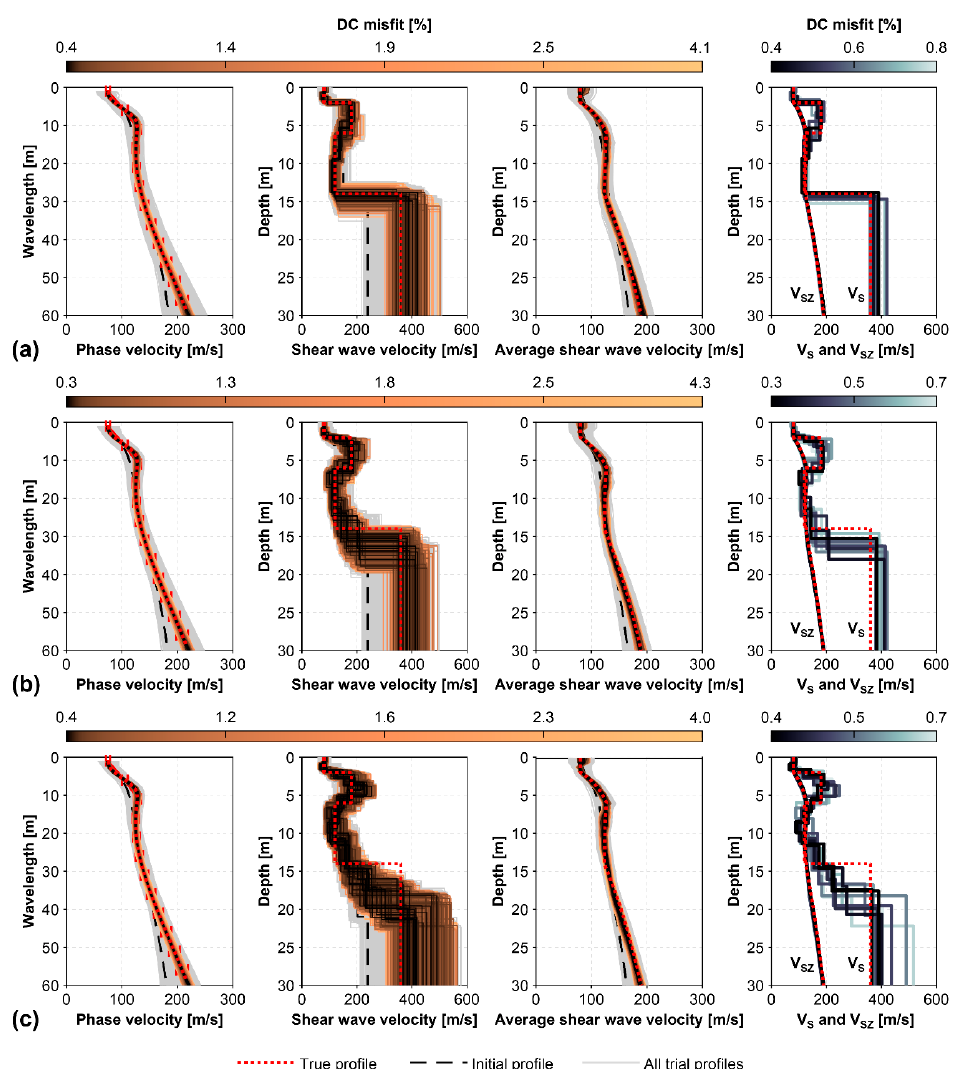
Figure 14. Inversion of the unperturbed synthetic dispersion curve from model C. A geologic structure consisting of ( a ) six, ( b ) eight and ( c ) twelve layers (including the half-space) was assumed.